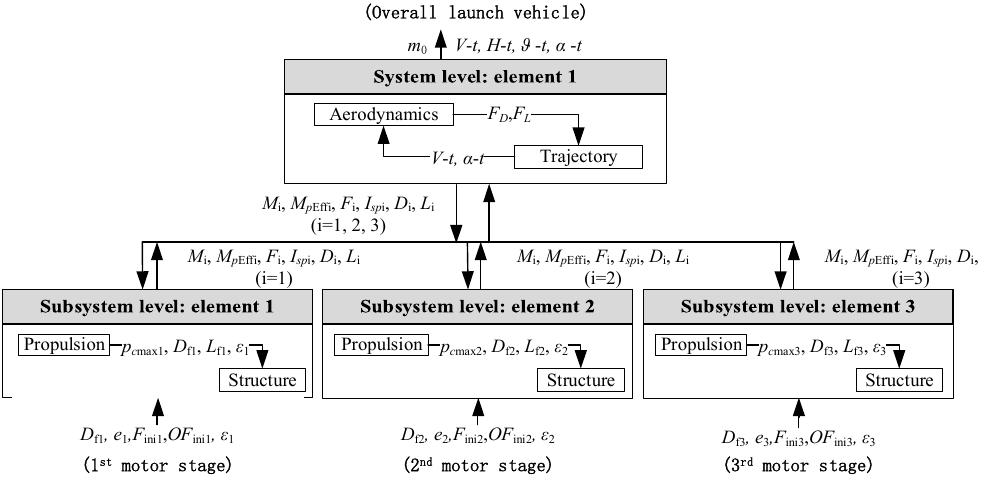
Figure 11. ATC decomposition framework of LV design based on multi-stages.